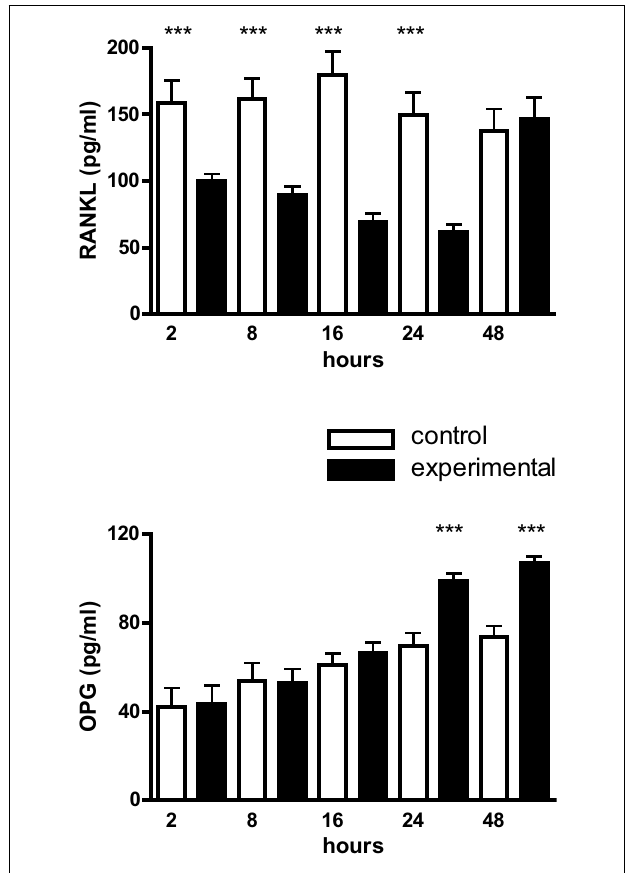
FIGURE 3 | RANKL and OPG production by mouse calvarial osteoblasts . Osteoblasts in monolayer culture were subjected to a cyclic tensile strain (6s every 90s) for 2–48h and the culture media assayed for RANKL and OPG by ELISAs. Results are expressed as mean ± SEM for 10 cultures. ***Experimental significantly different from control. P < 0.001.